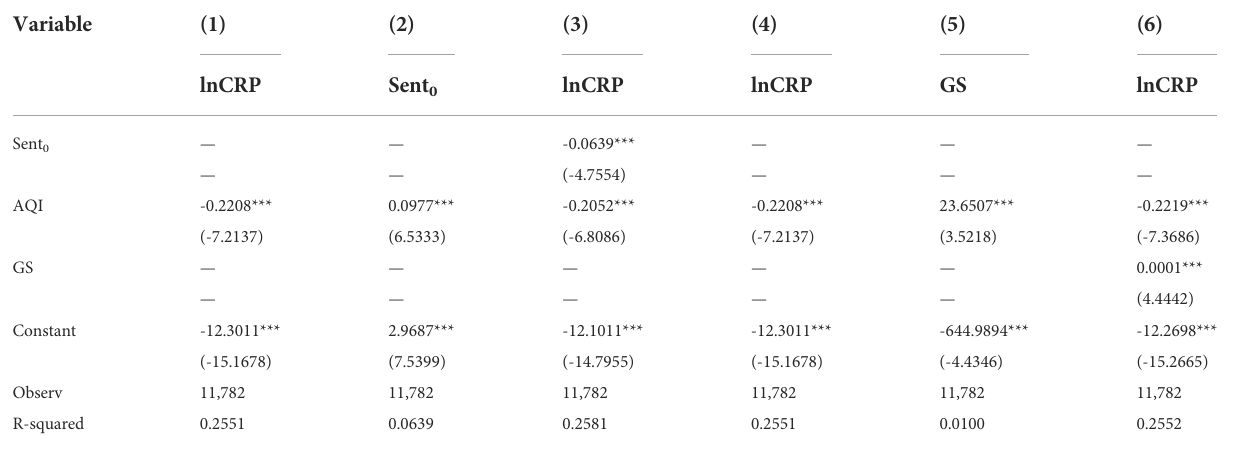
TABLE 15 Regression results of the variable substitution method.